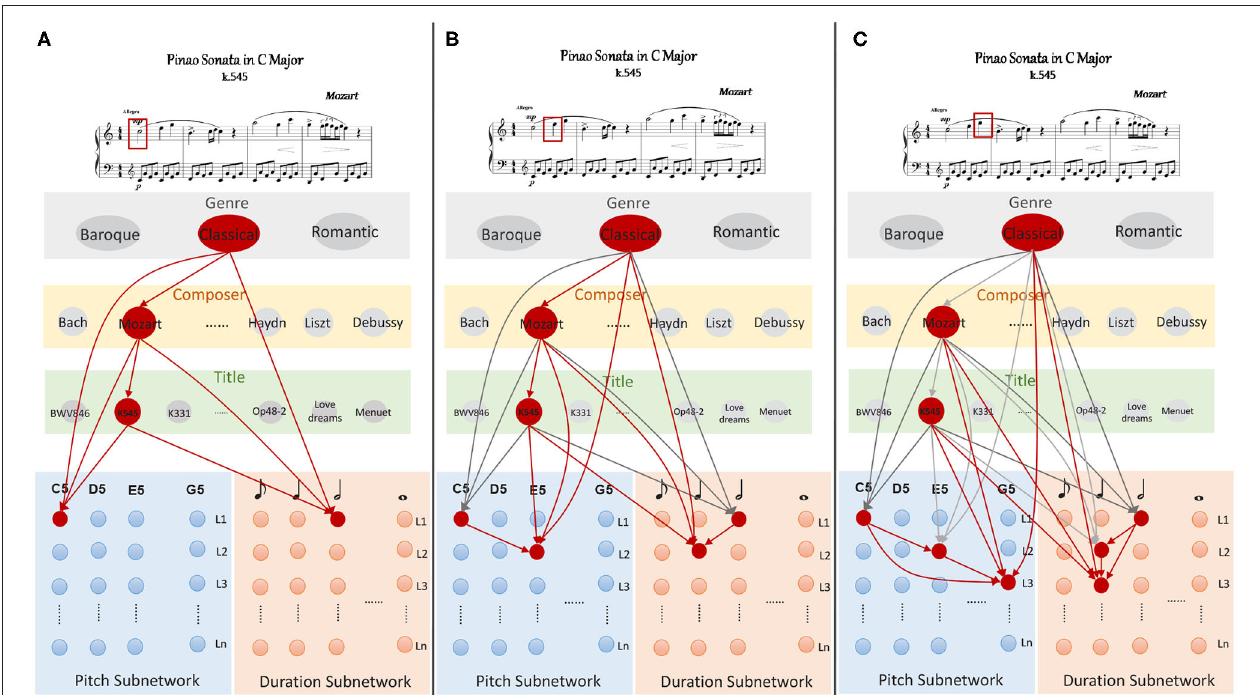
FIGURE 4 | The storing process of the work “K545” written by Mozart, (A) describes the learning process of the first note marked by a red rectangle, the second and the third notes are leaned and the corresponding synapses are potentiated using STDP in (B,C) .